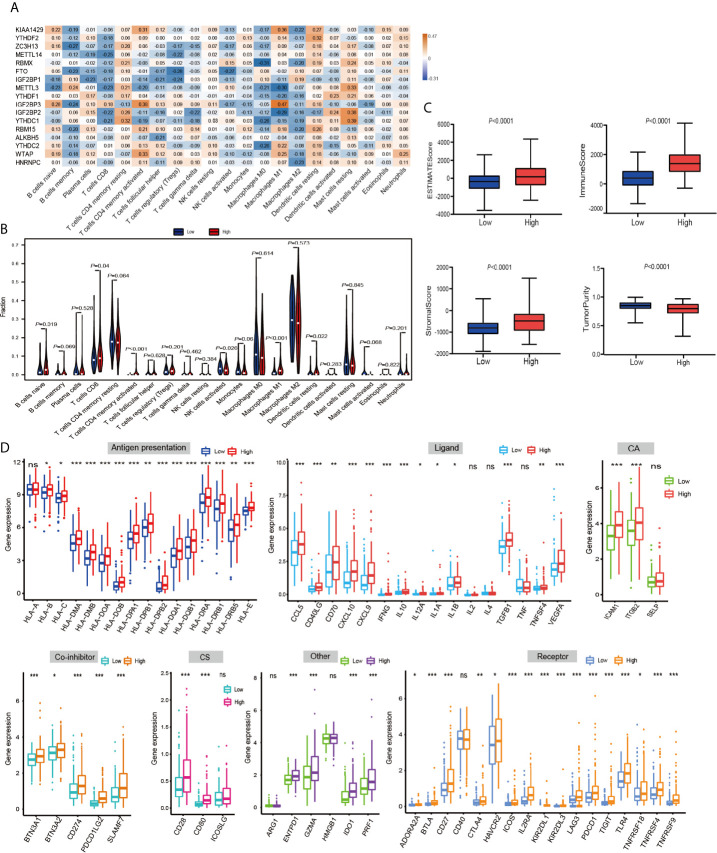
The relationship between the IGF2BP3 and the immune-related features in PRCC. (A) Spearman’s correlations between m6A RNA methylation regulators expression levels and immunomodulators. (B) The violin plot of the 22 immune cell proportions between high and low IGF2BP3 expression groups. (C) The difference in ESTIMATE scores, immune scores, and stroma scores between IGF2BP3 high expression and low expression subgroups. (P < 0.0001). (D) Effect of IGF2BP3 expression level on the expression of different immunomodulators. *P < 0.05, **P < 0.01, and ***P < 0.001.